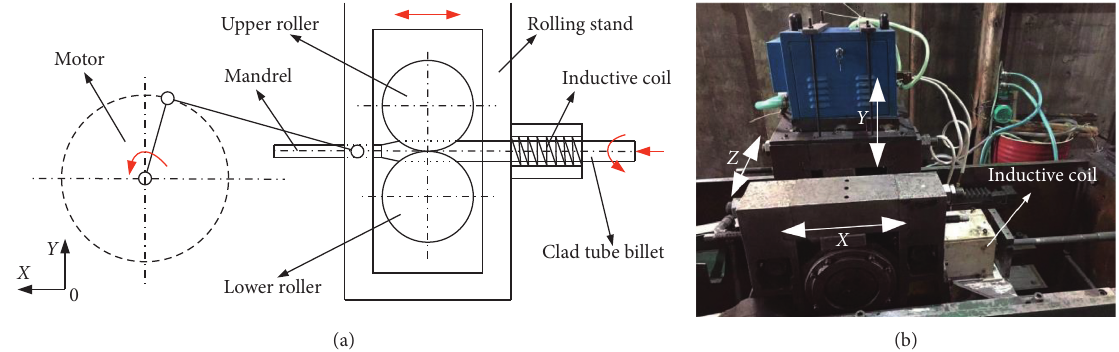
Figure 2: The pilger hot rolling clad tube principle diagram. (a) Schematic diagram. (b) Equipment.